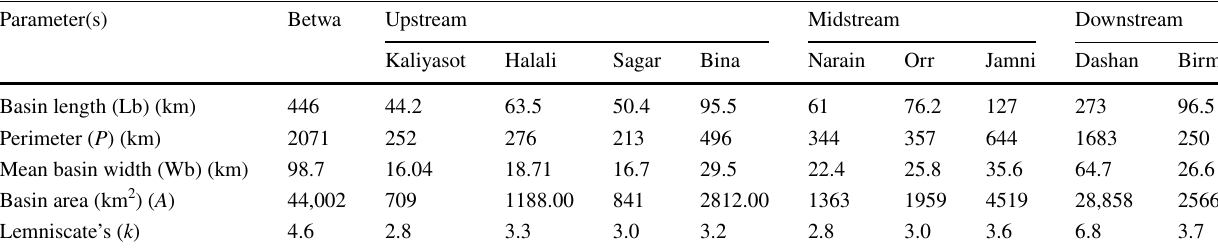
Table 4 Areal aspect of the Betwa River basin and sub-basins